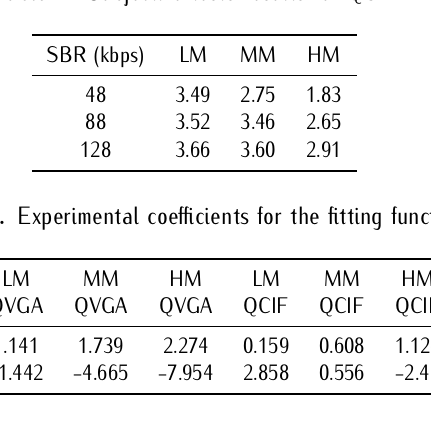
Figure 1. Boxplot of subjective testing results for encoding of QVGA sequences. Table 4. Subjective tests results for QCIF.